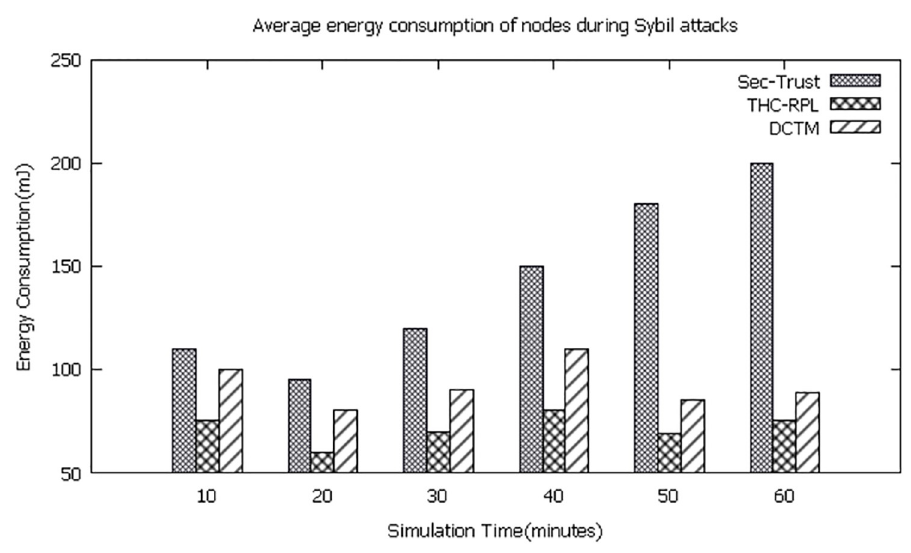
Fig 17. Computation